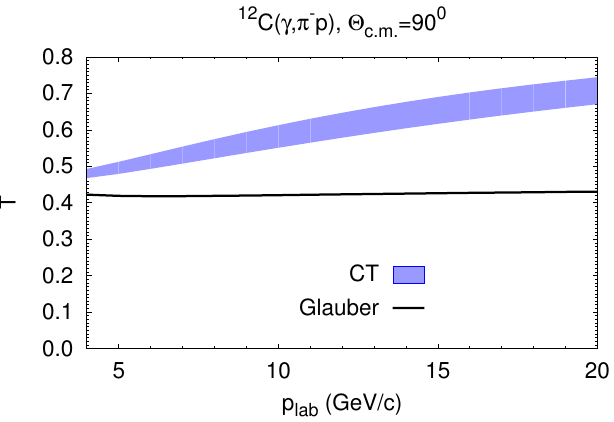
Figure 3. Transparency for the 12 C ( γ , π − p ) semiexclusive process at t = − 2 GeV 2 vs photon beam momentum. Calculations for the unresolved photon (UP) and resolved photon (RP) regimes are shown by the solid (black) and dashed (magenta) line, respectively.